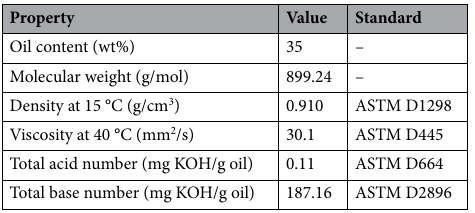
Table 1. Physicochemical properties of Camelina oil (Soheil cultivar).